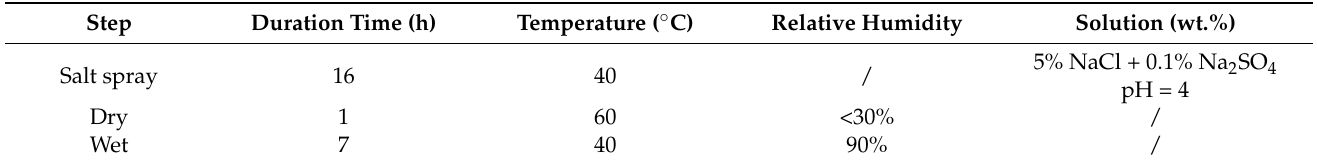
Table 3. Laboratory-accelerated test